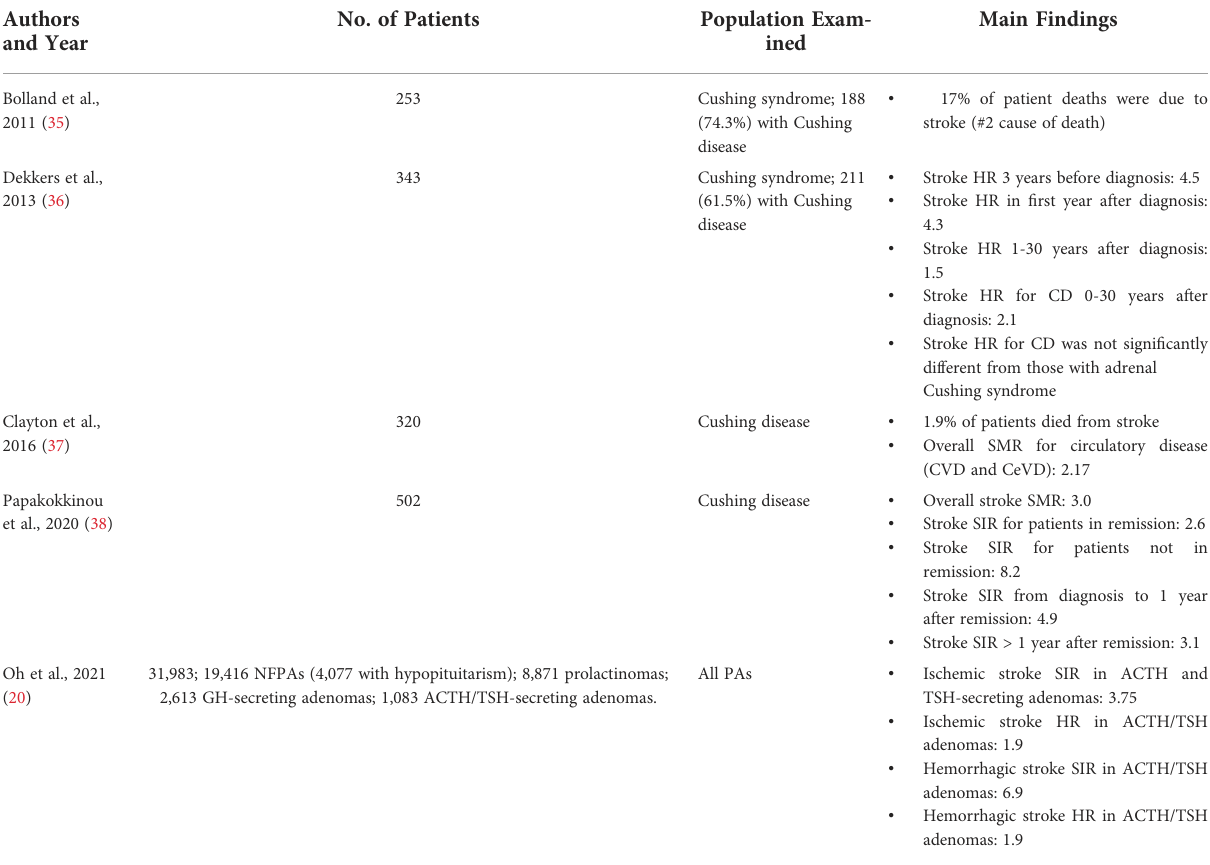
TABLE 2 Cerebrovascular outcomes related to PA patients with cushing disease. Authors and